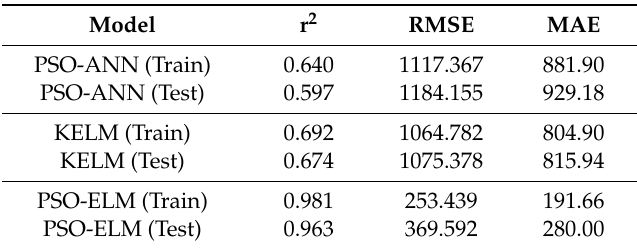
Table 2. Performance measures for the investigated